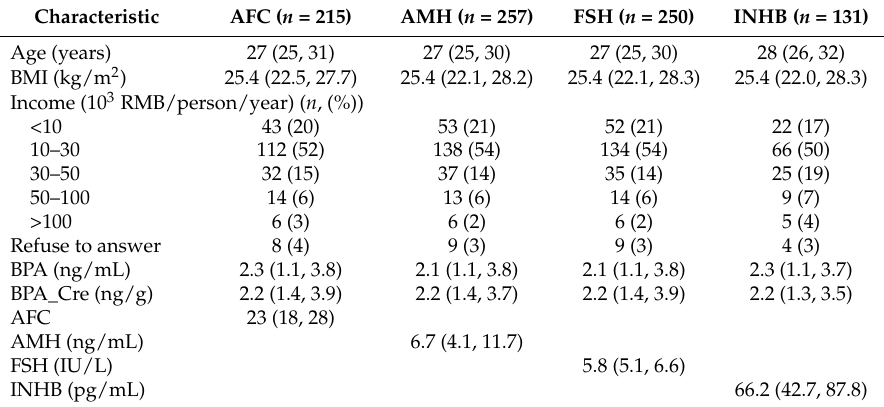
Table 1. Demographic characteristics and measures of ovarian reserve.